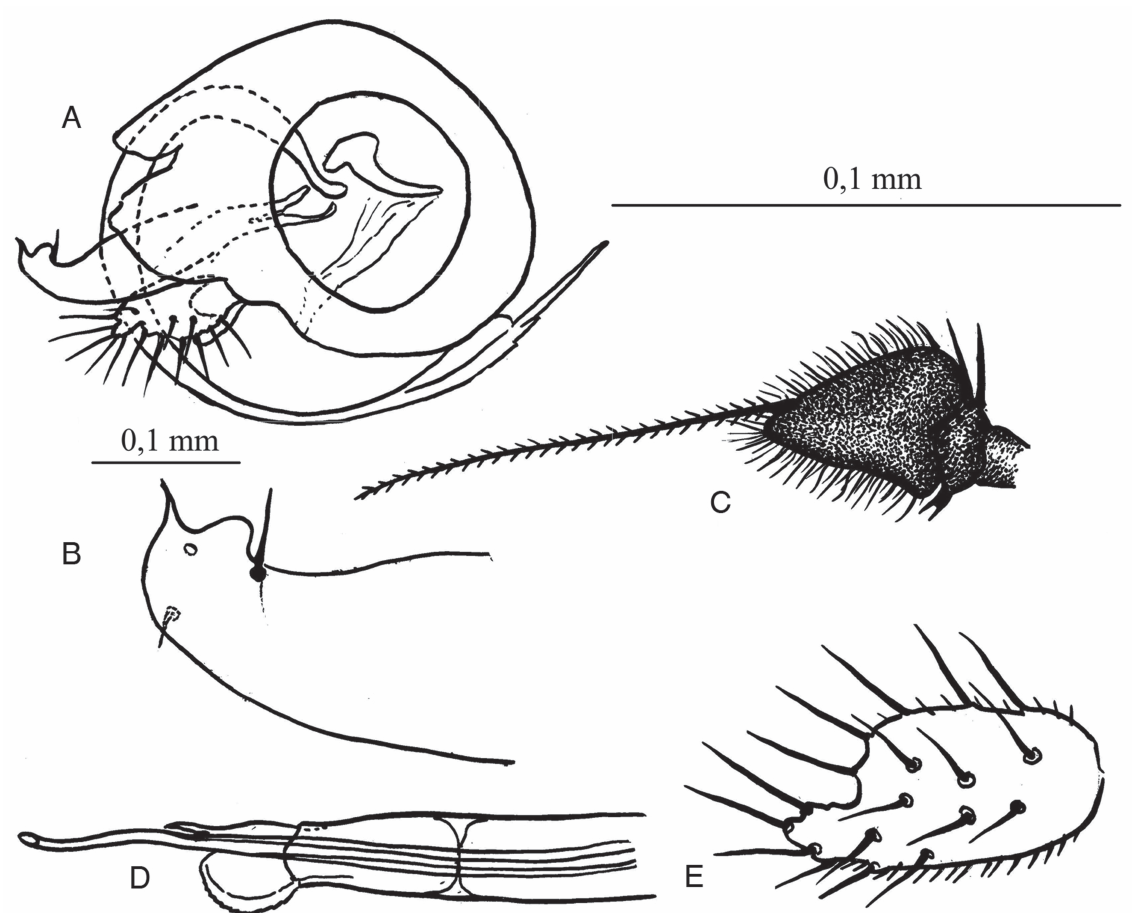
Fig. 1. Chrysotus masunagai Negrobov, Kumazawa & Tago sp. nov., ♂, paratype, coll. 28 Apr. 2012. A . Hypopygium, lateral view. B . Apex of surstylus, lateral view. C. Antenna. D . Apex of phallus, lateral view. E . Cerci, lateral